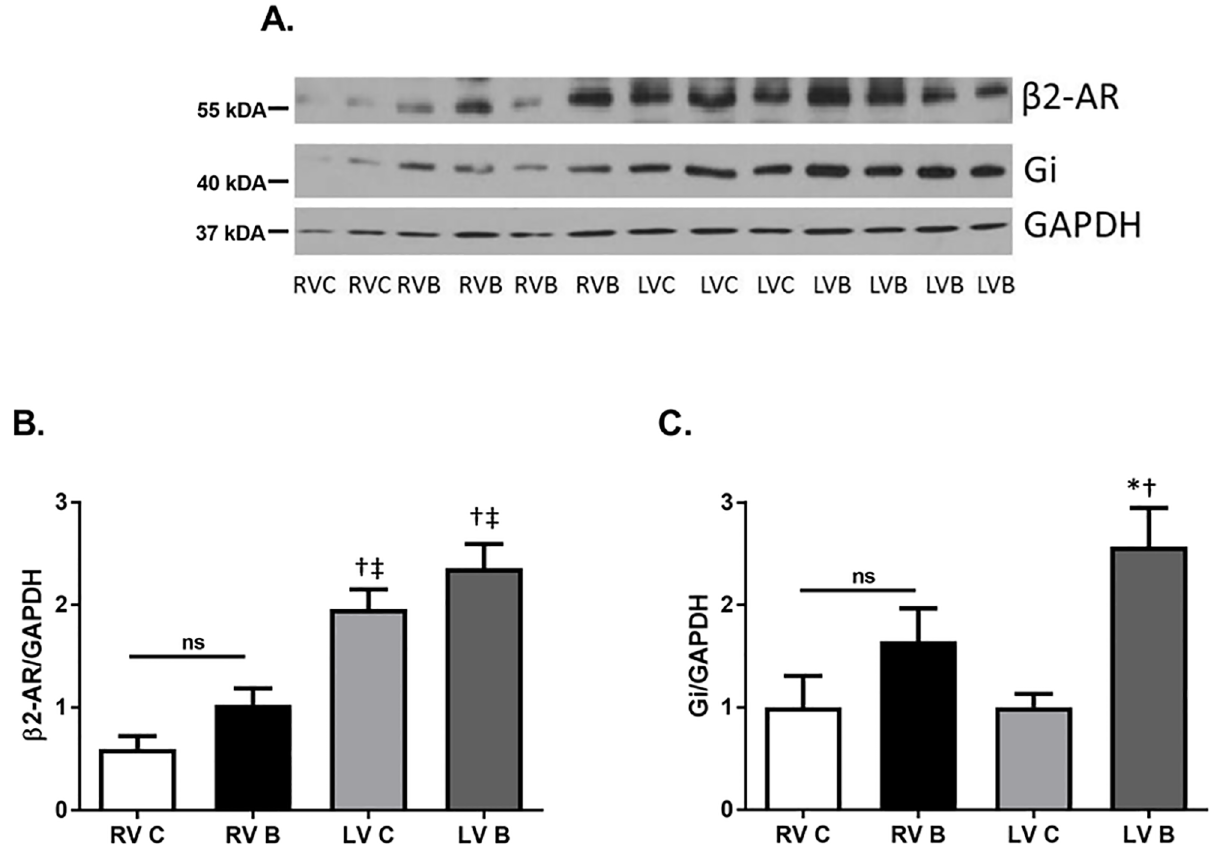
Fig 2. β 2 -AR and G i protein expressionpost-burn. Representative Western blots of β 2 -AR (A, B) and G i (A, C) protein expressionin right and left ventriclesseven days post-burn. Controls were nonburnedanimals. The bar graphs show the ratio of protein to GAPDH. Data are expressedas the mean ± SEM. Statistical analysiswas performed using a one-wayANOVA. n = 9–12; p < 0.0001for β 2 -AR; p = 0.011 for G i ; RV C: right ventricle control; RV B: right ventricleburned; LV C: left ventriclecontrol; LV B: left ventricleburned; β -AR, beta adrenergic receptor; †, p < 0.05vs RV C; ‡, p < 0.05vs RV